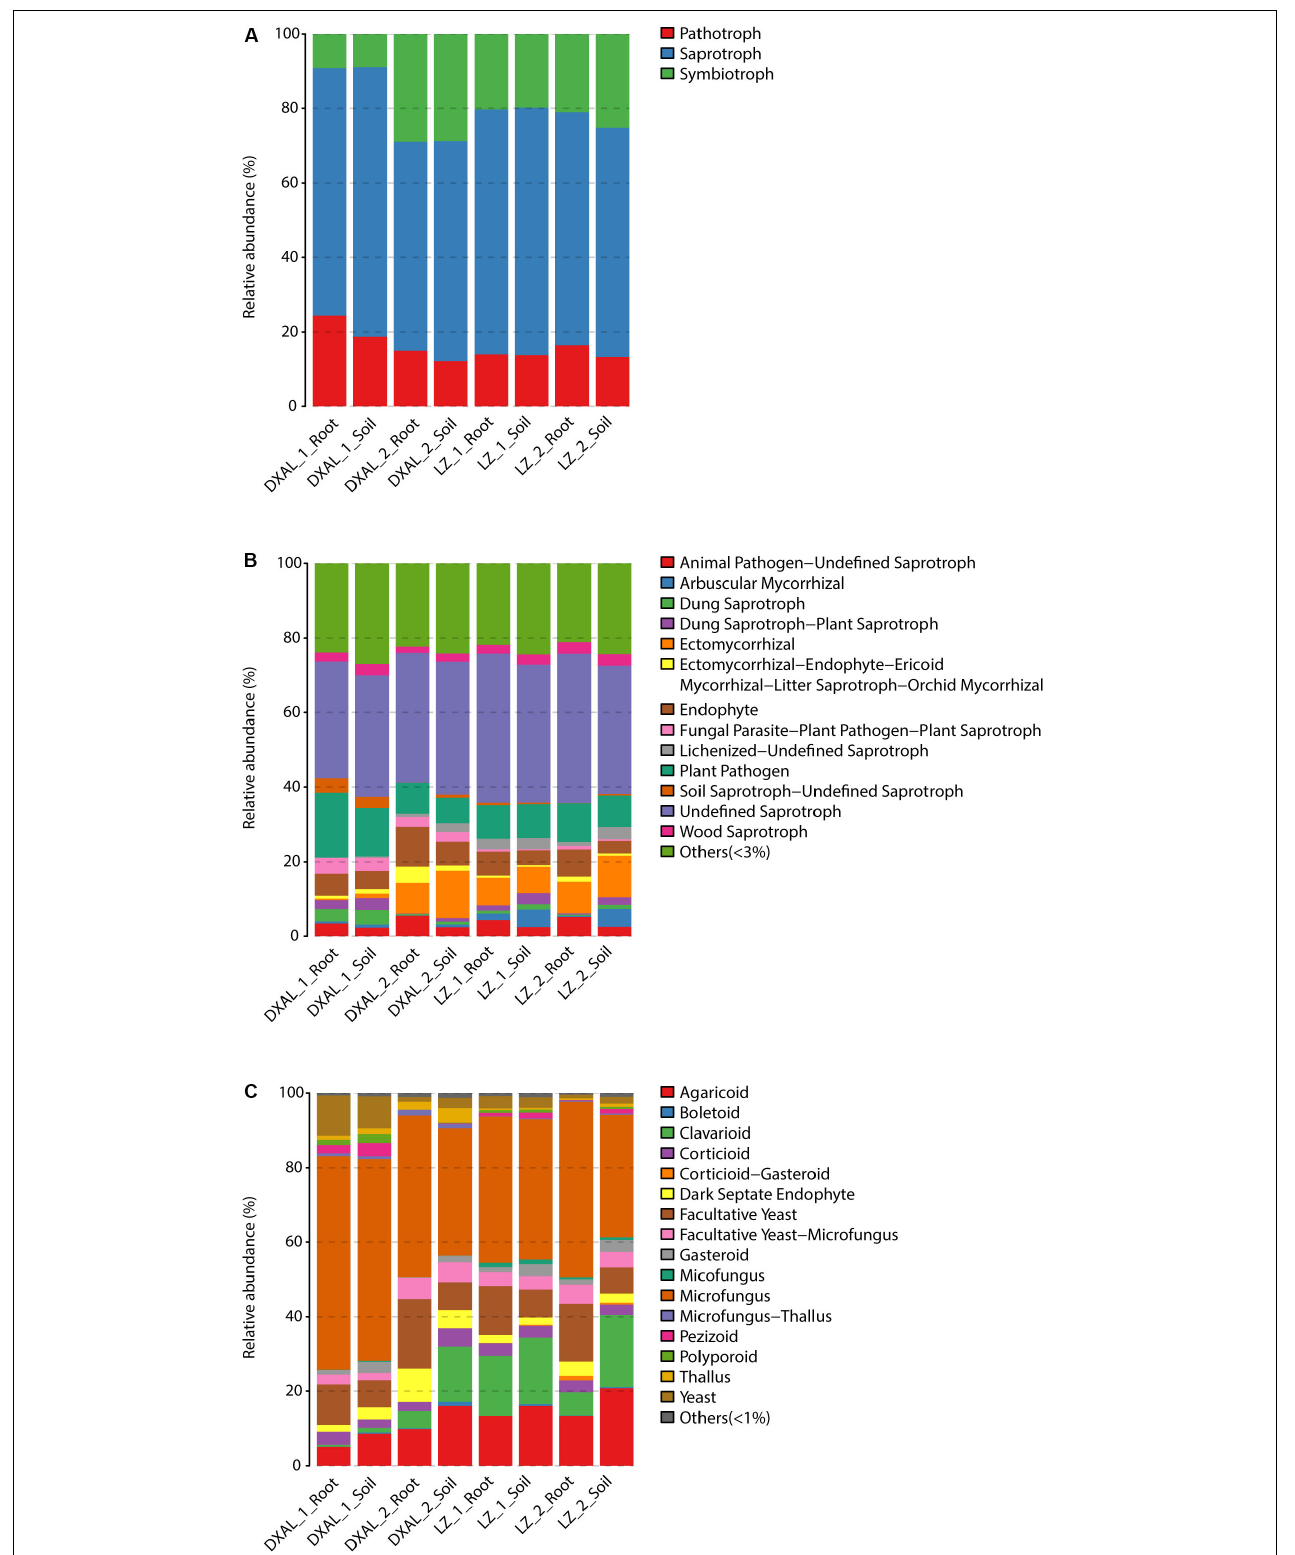
FIGURE 4 | Compositions of fungal functional group (guild) inferred by FUNGuild. (A) At the trophic mode level. (B) At guilds level. (C) At Growth_Morphology level. DXAL: Greater Khingan Mountains, LZ: Linzhi, 1: vegetative growth stage, 2: reproductive growth stage.